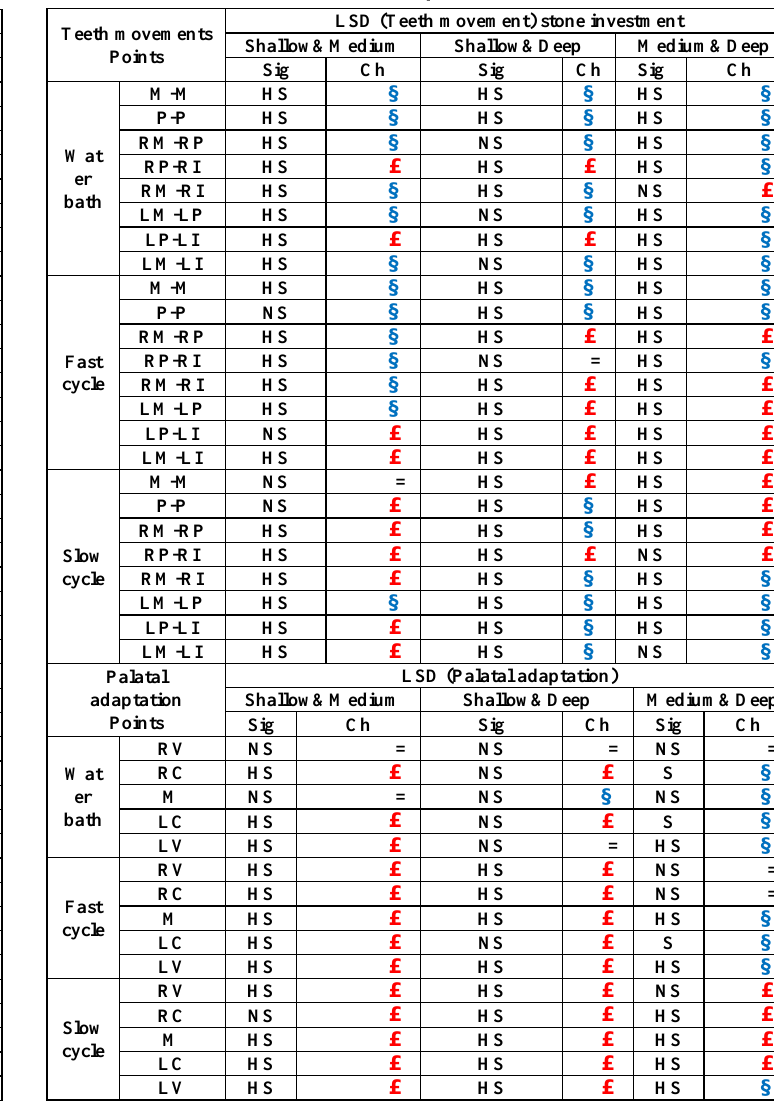
Table 3: LSD test for the comparison between the curing methods and stone investment for palatal depths in teeth movements and palatal